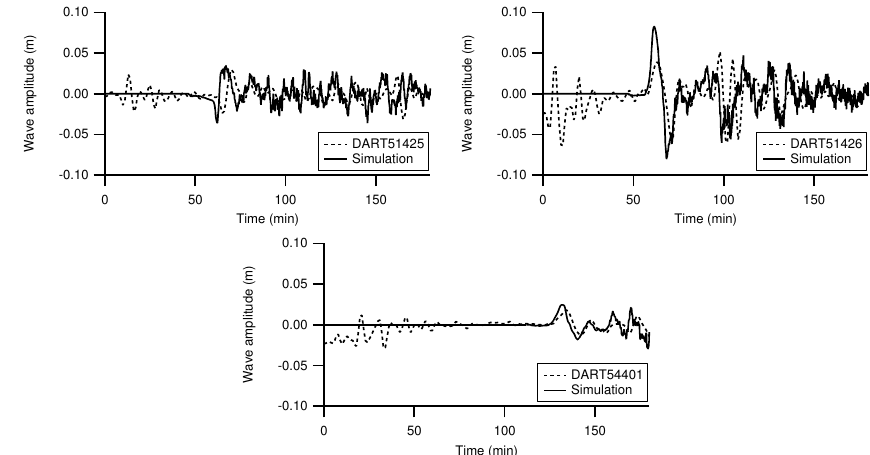
Figure 3. Comparison of the modeled waveforms from the tsunami propagation model and observed waveforms at the DART gauges. The tsunami source model is used for modeling tsunami inundation.